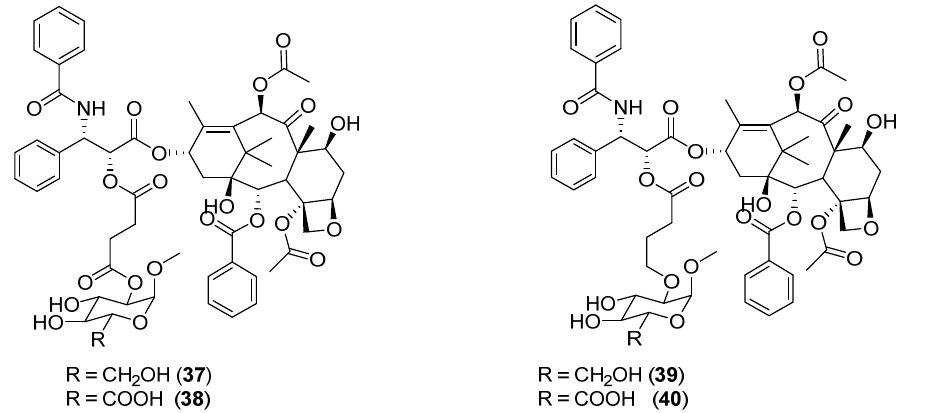
Figure 6. Glucose and glucuronic acid derivatives (i.e., 37 and 38 ) of paclitaxel ( 7 ) displaying im- proved selectivity via LEAPT [77]. improved selectivity via LEAPT